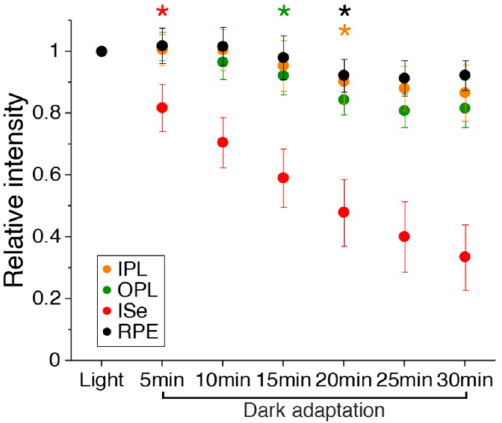
Figure 3. Relative OCT intensity measurement of hyper-reflective bands in the retina. Data are represented as mean with 95% confidence intervals (error bars). Significant differences between time points were tested using a one-way repeated measures ANOVA with Bonferroni’s post-hoc tests. N = 14. Asterisks indicate the earliest time point showing a statistically significant difference (* p < 0.05) in each band compared to the baseline light- adapted measurement.